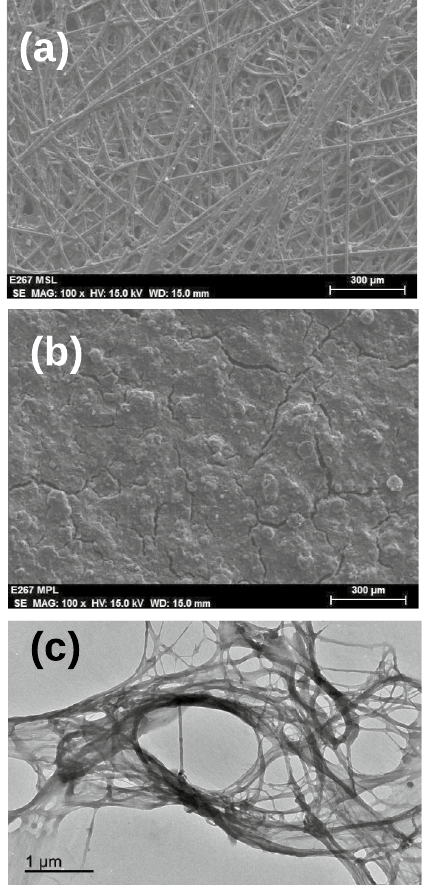
Figure 1. SEM images of the MPS ( a ) and MPL ( b ) of the GDL with a 40% in cotton fiber. TEM image of the natural cotton fibers used in this work ( c